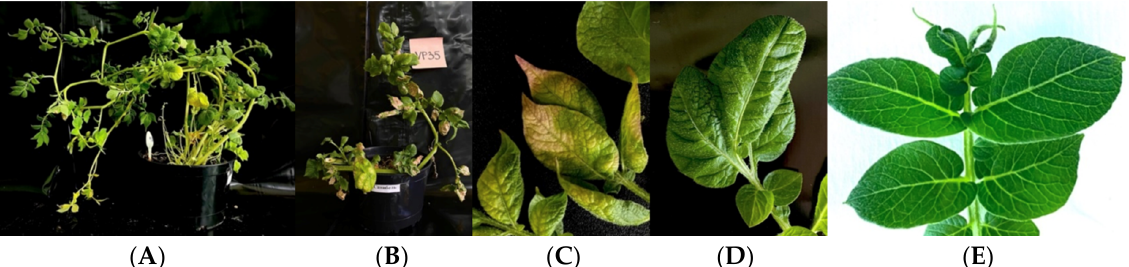
Figure 3. Symptoms of viroid infection on the haulm of different potato cultivars: ( A )—cv. Arizona, strain NicTr-3; ( B )—cv. Sanibel, strain VP35; ( C )—cv. Sprinter, strain NicTr-3; ( D )—cv. Favorit, strain NicTr-3; ( E )—cv. Gala, strain VP87.